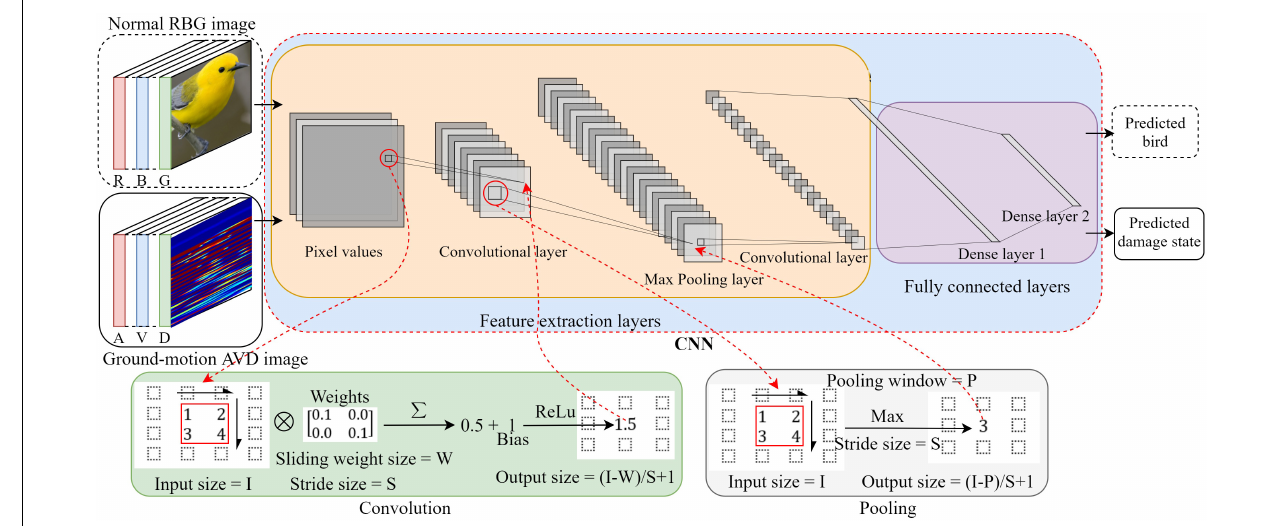
FIGURE 2 | A CNN architecture to predict image classes. Features are automatically extracted in convolutional layers and max pooling layers. The extracted features are fed to the fully connected layers for